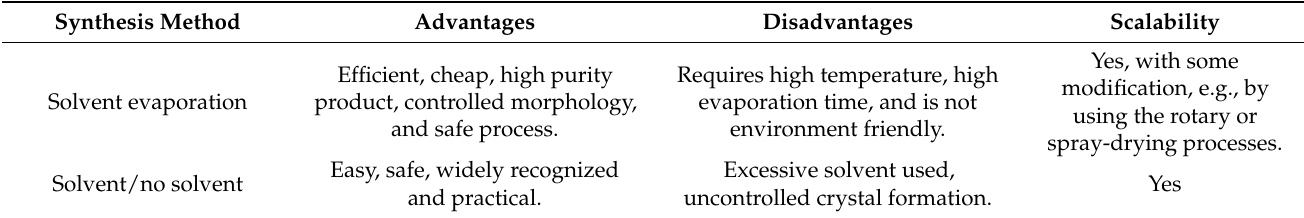
Table 1. Synthesis methods of energetic cocrystal